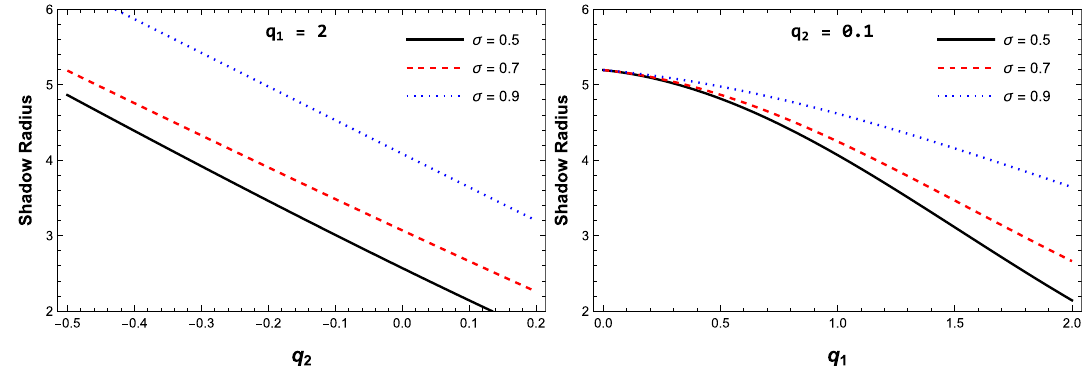
Fig. 9 The dependence of shadow radius on q 1 and q 2 for three values of σ . The solidblack lines, dashed red linesand dotted green lines correspond to σ = 0 . 5, σ = 0 . 7 and σ = 0 . 9, respectively. In the left plot q 1 is fixed and in the right plot q 2 is